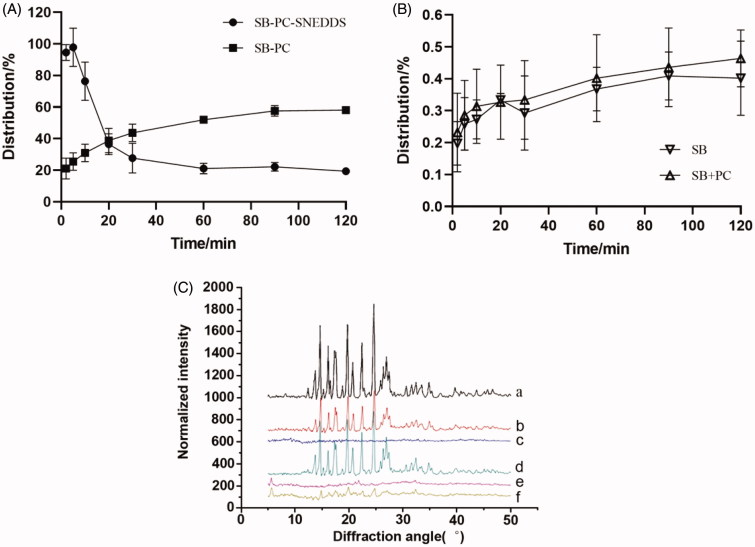
Analysis of isolated digestion phases in vitro lipolysis. (A) Distribution (%) of SB in the liquid phase throughout the in vitro lipolysis of the SB–PC and SB–PC–SNEDDS. (B) Distribution (%) of SB in the liquid phase throughout the in vitro lipolysis of the SB and SB + PC. (C) XRD patterns of (C-a) SB-starting crystalline SB used in SNEDDS; (C-b): SB (lipolysis)-pellet from the lipolysis of SB; (C-c) SB–PC (lipolysis)-pellet from the lipolysis of SB–PC; (C-d) SB + PC (lipolysis)-pellet from the lipolysis of the physical mixture of SB and PC; (C-e) SB–PC–SNEDDS (lipolysis)-pellet from the lipolysis of SB-SNEDDS; (C-f) blank SNEDDS (lipolysis)+SB-pellet from the lipolysis of blank SNEDDS spiked with SB.